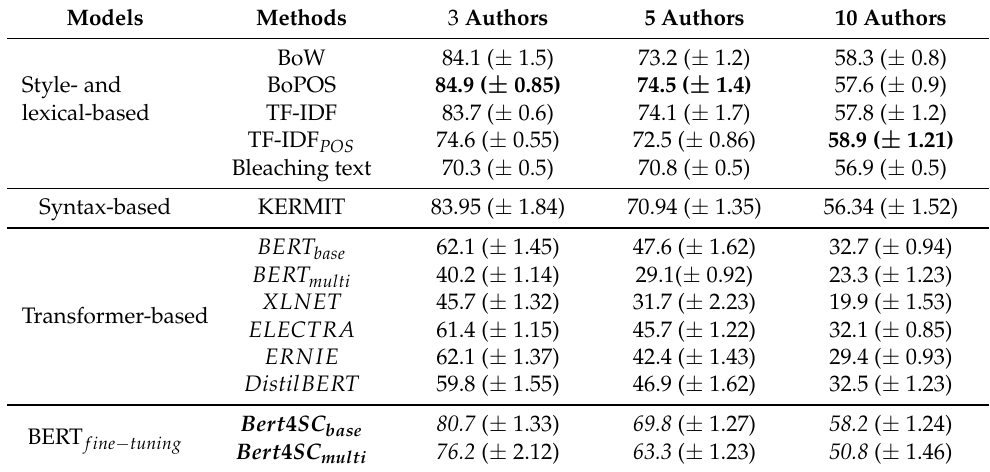
Table 2. Comparison of the different performances of the proposed models on the authorship attribution task on the Islamic Network